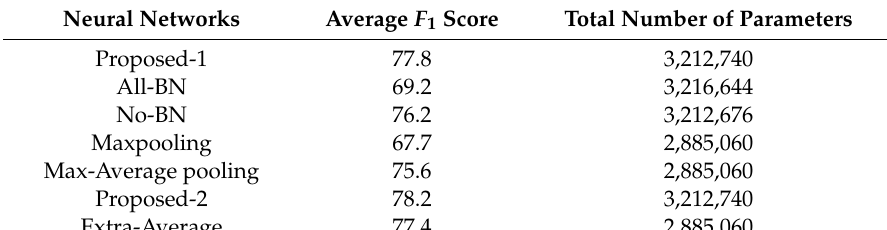
Table 6. Average F 1 scores of proposed networks and their variants.